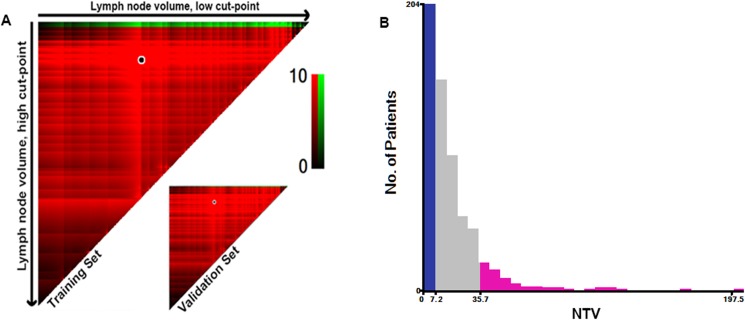
X-tile analysis of 1230 patients with newly diagnosed stage T1-4N1-3M0 nasopharyngeal carcinoma (NPC) reveals a continuous distribution based on nodal tumor volume.A shows nodal tumor volume divided at the optimal cut-points (7.2 cc and 35.7 cc, P = 0.03), as defined by the most significant (brightest pixel) on the plot.